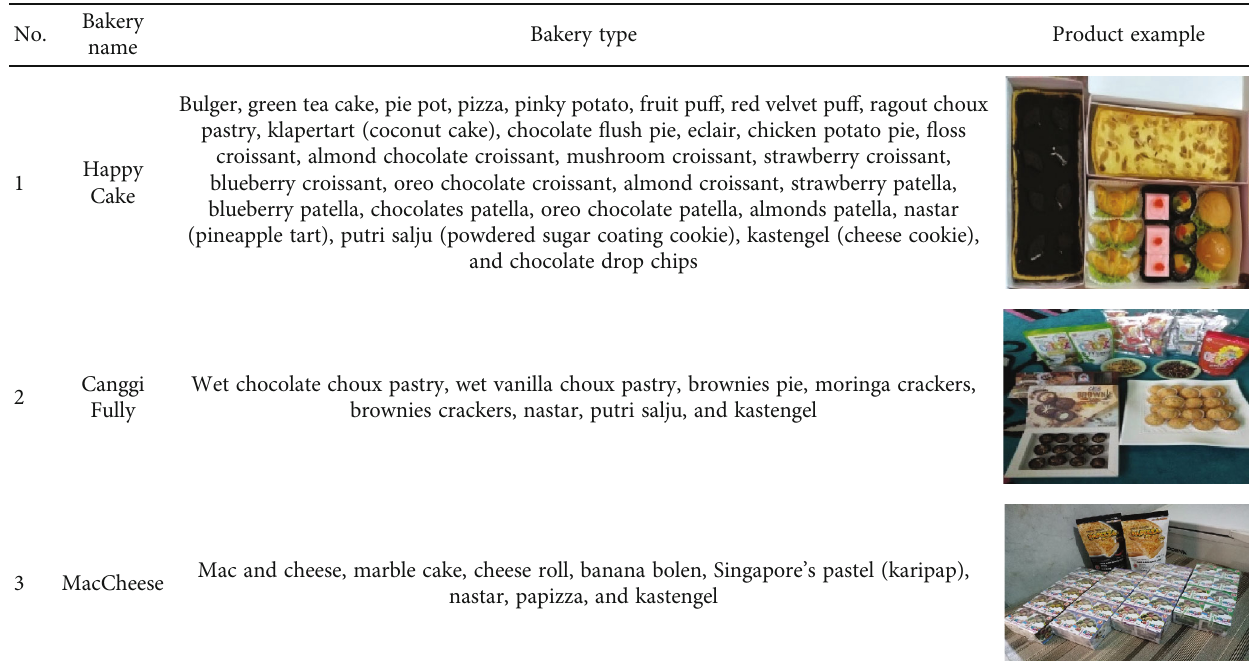
Table 1: List of bakery